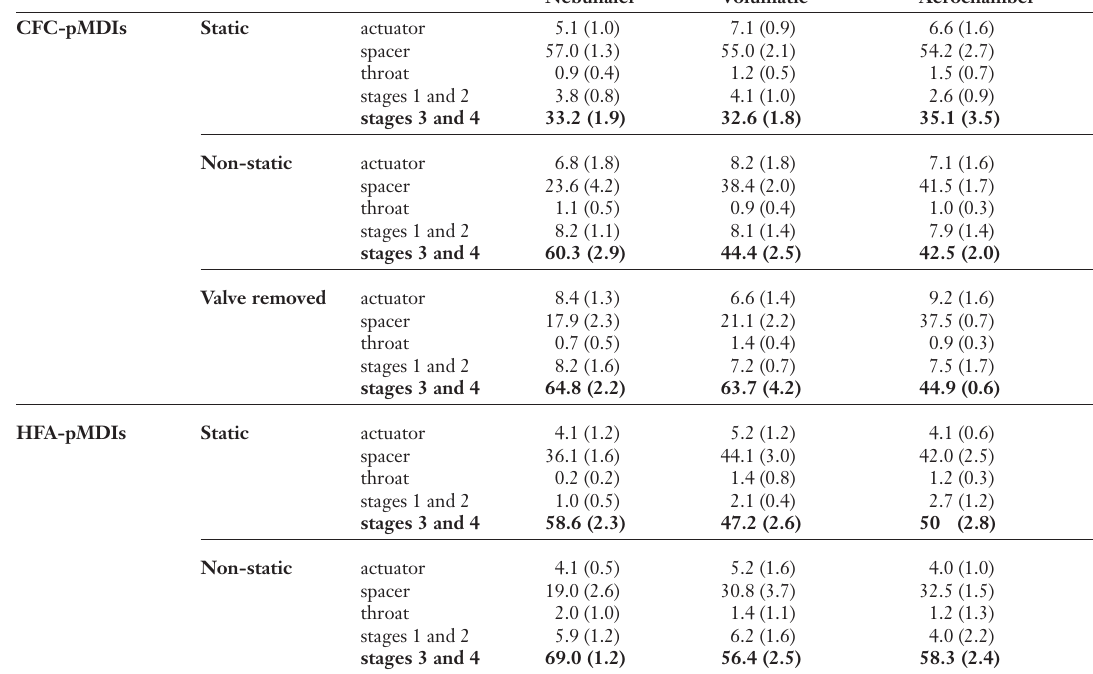
Influence of various factors, such as the propellant used, elec- trostatic charge on the surface and design of the spacer, on the mean percentage (SD) drug output* of salbu- tamol through large (Nebuhaler ® and Volumatic ® ) and small (Aerochamber ® )